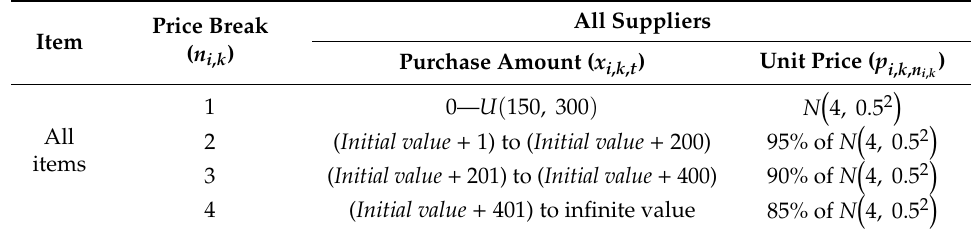
Table 6. Discount schedules of